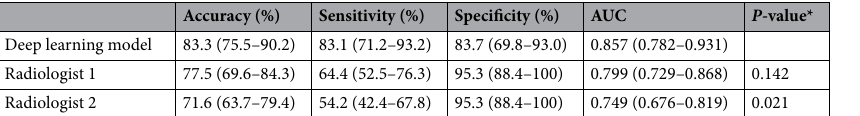
Table 2. Diagnostic performance of deep learning model and radiologists. AUC area under the receiver operating characteristics curve. * P -values calculated using DeLong’s method for comparing AUCs between the deep learning model and the two radiologists. Numbers in parentheses indicate 95% confidence